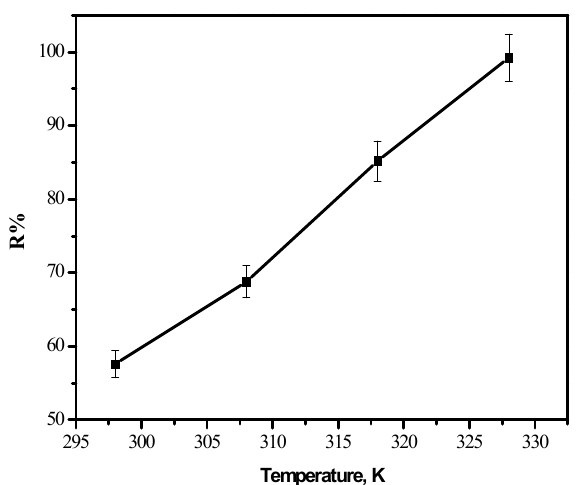
Figure 12. Effect of temperature on the efficacy of the removal of Pb(II) ions from synthetic wastewater by the GA/MNP composite.